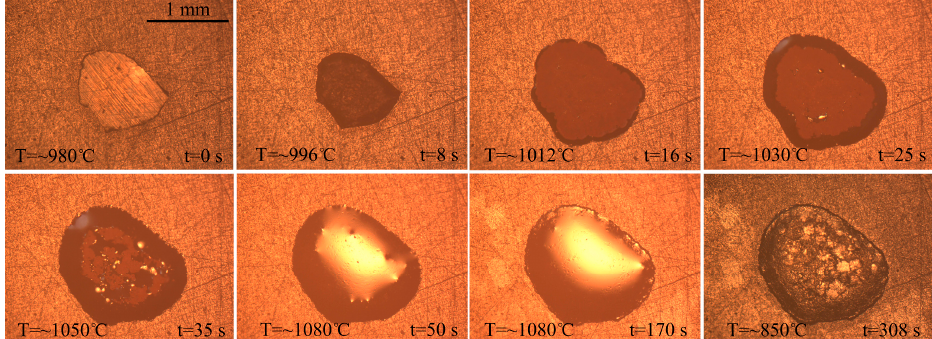
Figure 11. The representative instantaneous images of the spreading process of the BNi2 filler metals over the conventional forged TC4 substrates at 1080 °C.